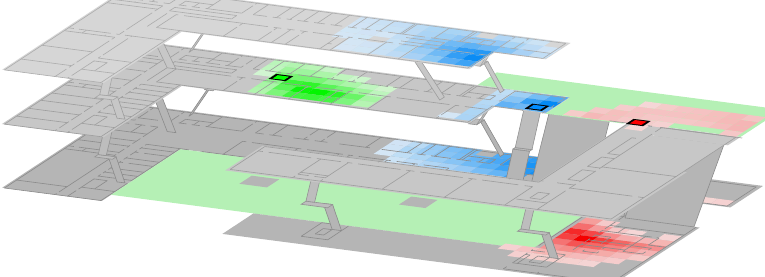
Figure 9. Wi-Fi-only location probability for three distinct scans where higher color intensities denote a higher likelihood for Equation (14). The first scan (left, green) depicts a best-case scenario, where the region around the ground truth (black rectangle) is highly probable. Often, other locations are just as likely as the ground truth (second scan, blue), or the location with the highest probability is far from the actual ground truth (third scan, right,